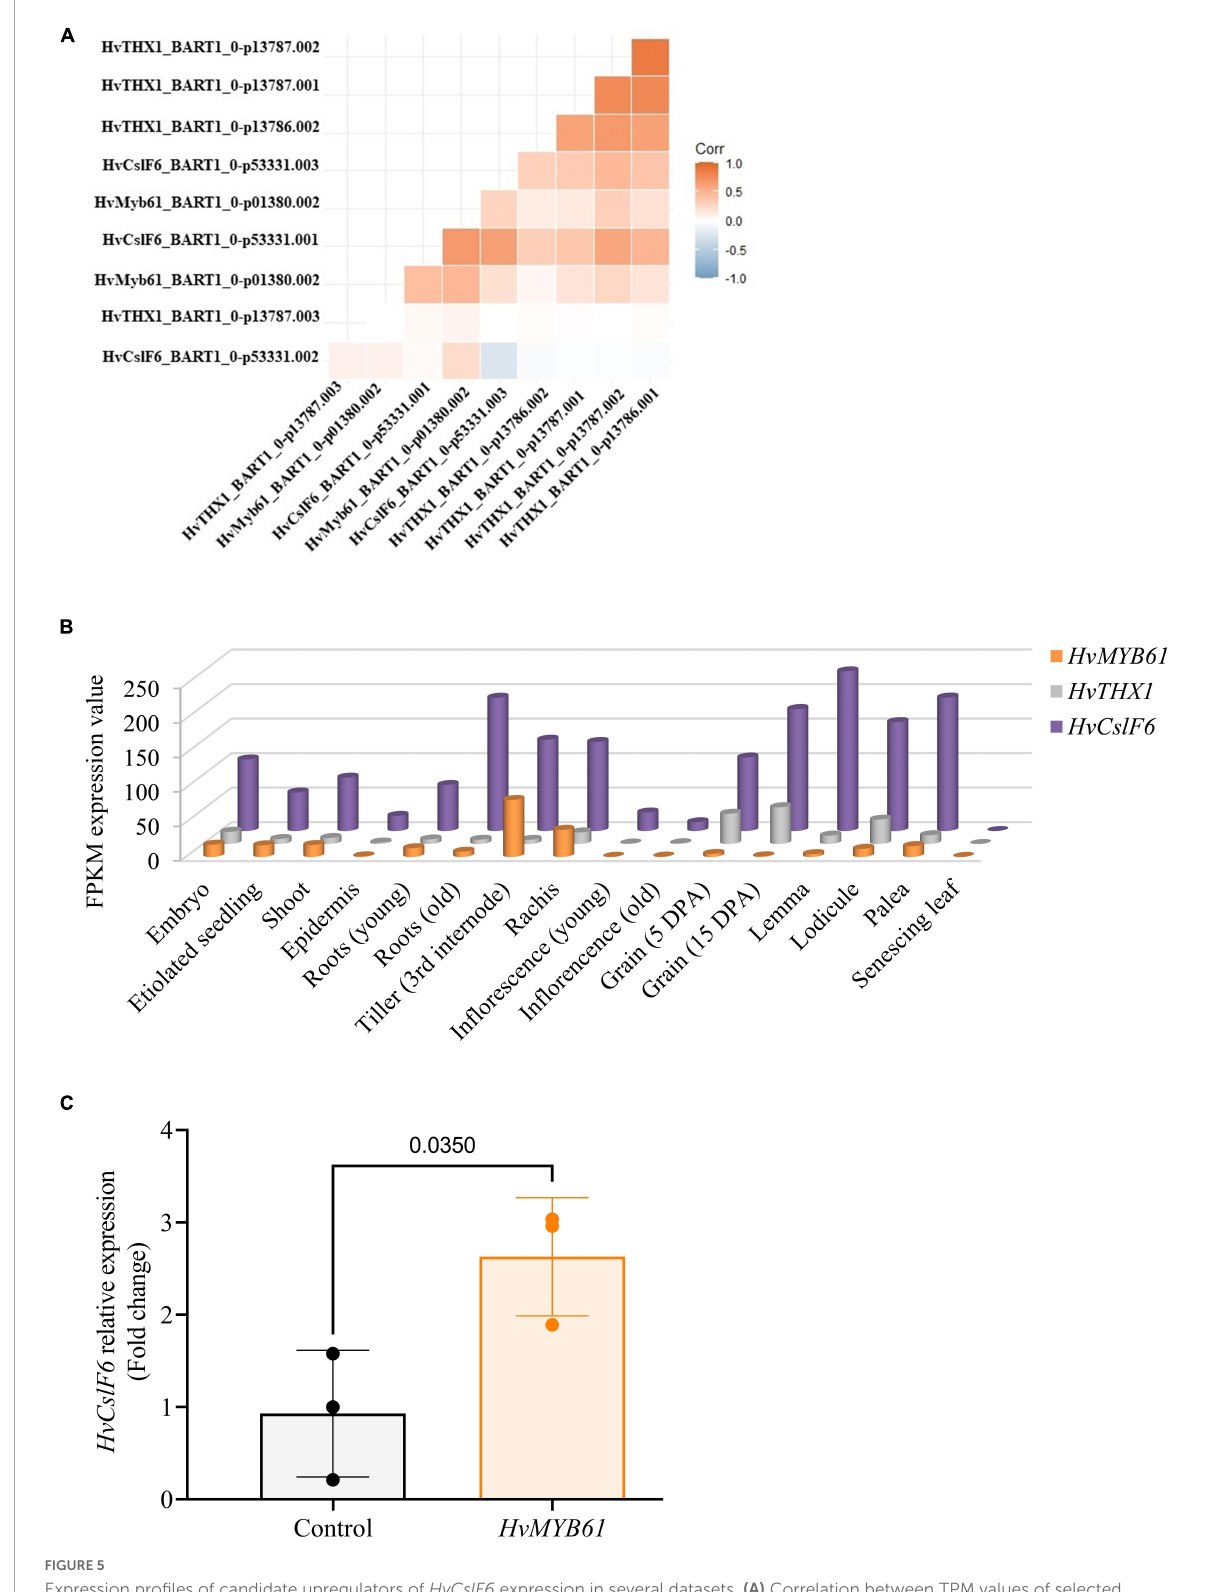
FIGURE5 Expression profiles of candidate upregulators of HvCslF6 expression in several datasets. (A) Correlation between TPM values of selected candidate genes from the EoRNA database ordered based on hierarchical clustering. (B) Expression levels of HvMYB61 candidate